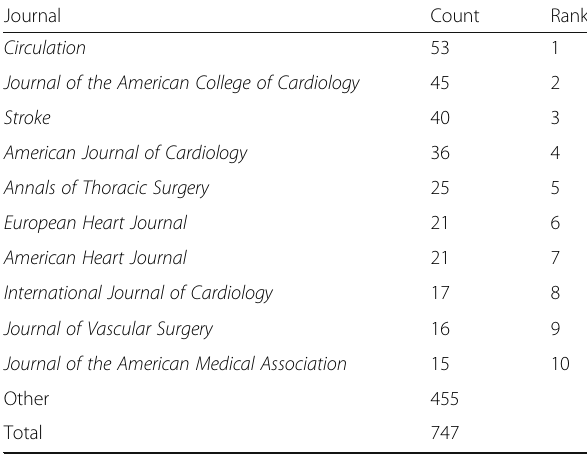
Table 1 Journals ranked by number of CPMs published